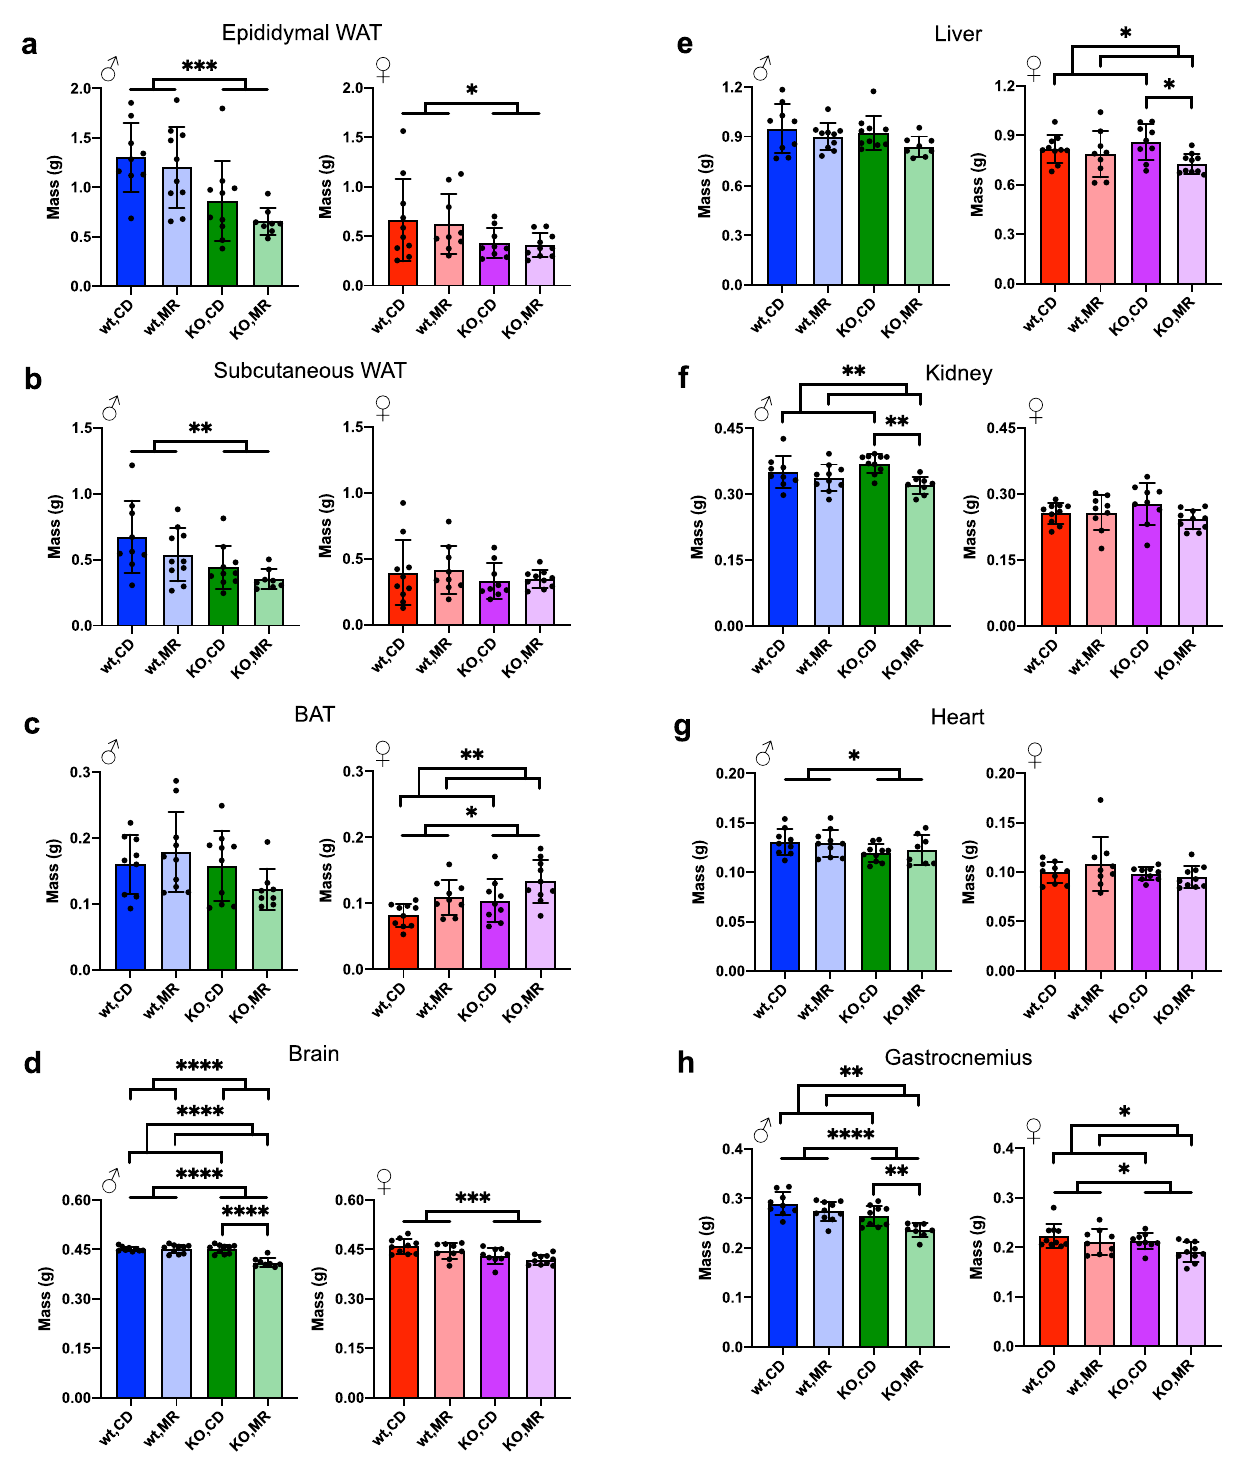
Figure 2. MR has sex-specific effects on tissue masses. Tissue masses for Epididymal WAT ( a ), Subcutaneous WAT ( b ), BAT ( c ), Brain ( d ), Liver ( e ), Kidney ( f ), Heart ( g ), and Gastrocnemius ( h ) were measured at time of collection. Analysis was within each sex via Two-Way ANOVA for main effects. Post-hoc analysis was performed with Sidac multiple comparisons correction to assess the diet effect within each genotype. Graphs represent means ± s.d. and all groups were 8–10 mice. (* p < 0.05; ** p < 0.01; *** p < 0.001; **** p <